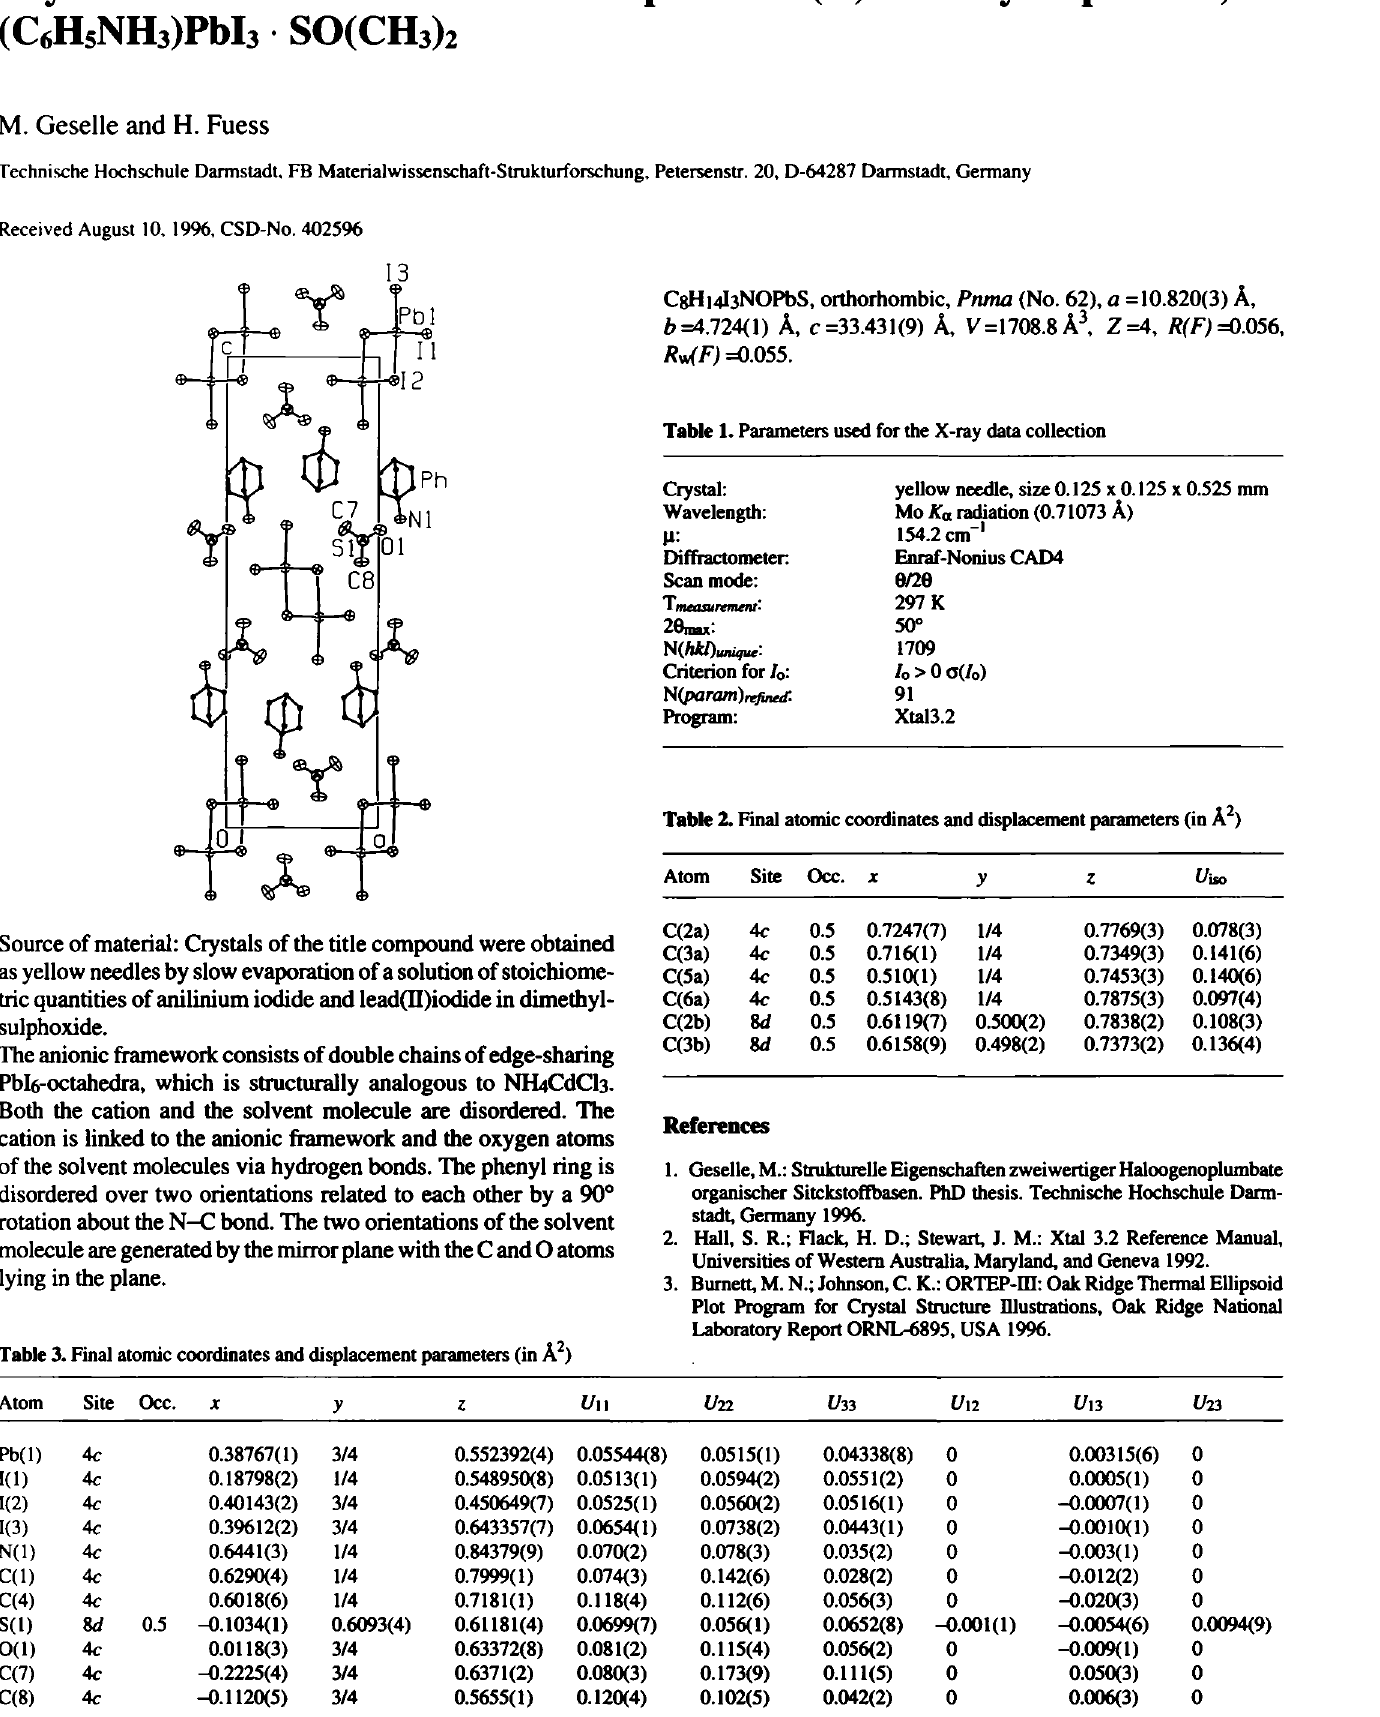
Table 3. Final atomic coordinates and displacement parameters (in Â 2 ) Atom